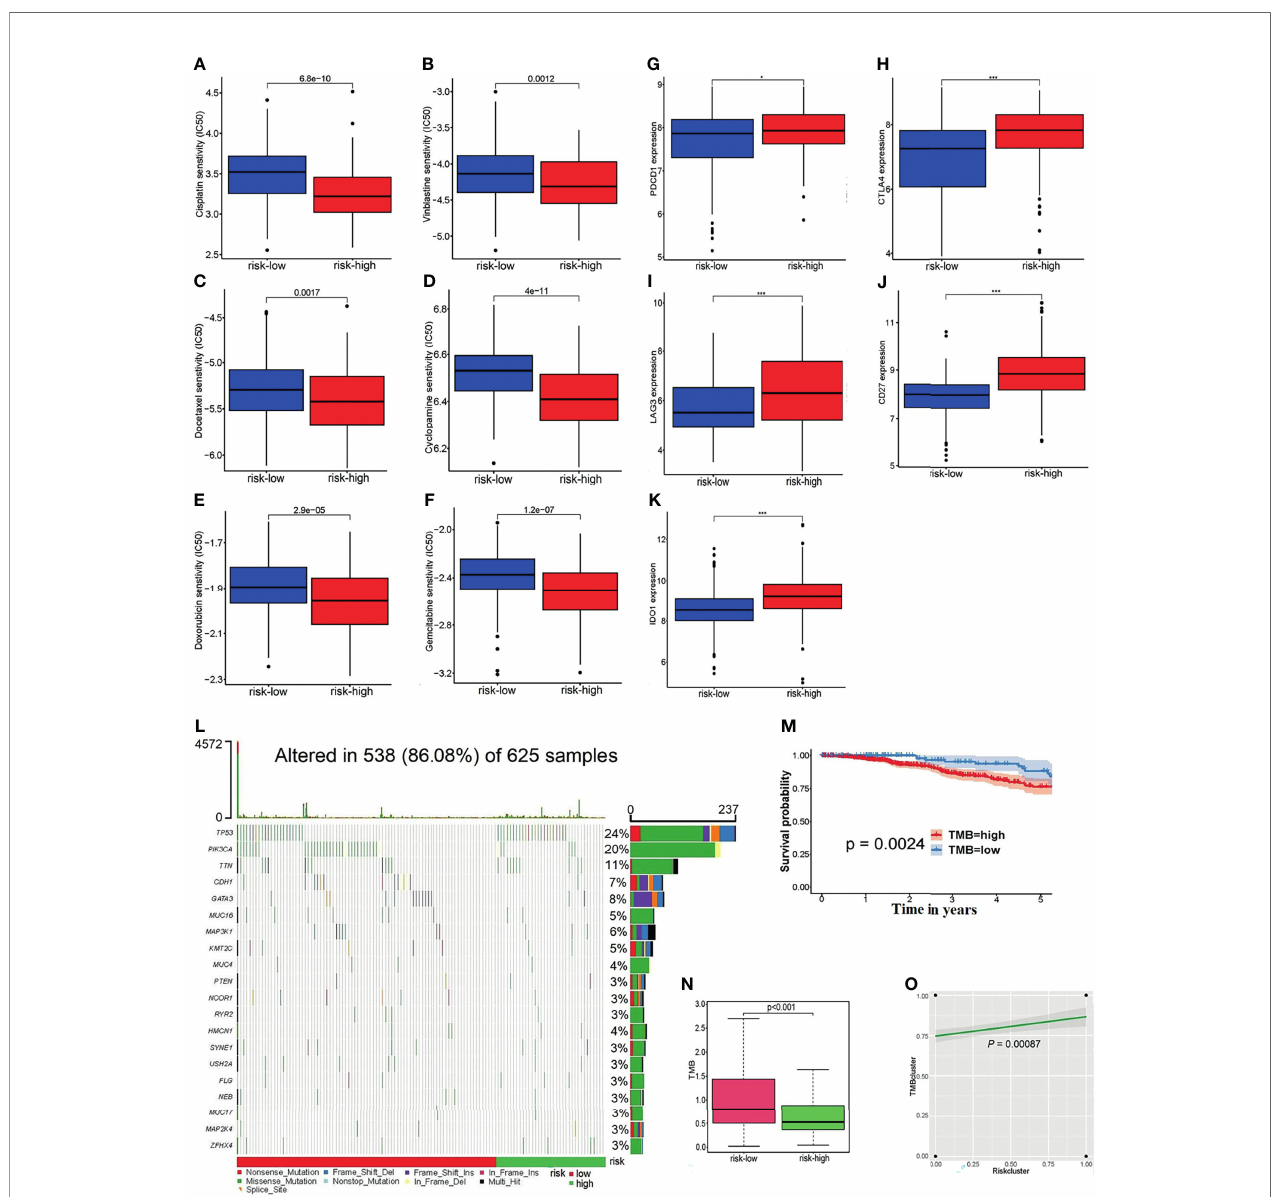
FIGURE 7 | (A – F ) The linkages between the risk grouping and some common chemotherapy agents for BC, for example, (A) cisplatin, (B) vinblastine, (C) docetaxel, (D) cyclopamine, (E) doxorubicin, and (F) gemcitabine. (G – K) Analyses of the relationship of ICs with the risk score, including (G) PDCD1 , (H) CTLA4 , (I) LAG3 , (J) CD27 , and (K) IDO1 . (L) The waterfall diagram of the altered genes in 625 samples. (M) The survivorship curve indicates that patients with low TMB scores have a longer survival time ( P = 0.0024). (N) The boxplot re fl ects the correlation between the risk cluster and the TMB score ( p = 0.0024). (O) There was a positive association between the risk clusters and TMB clusters ( p = 0.00087).*p < 0.05, ***p <